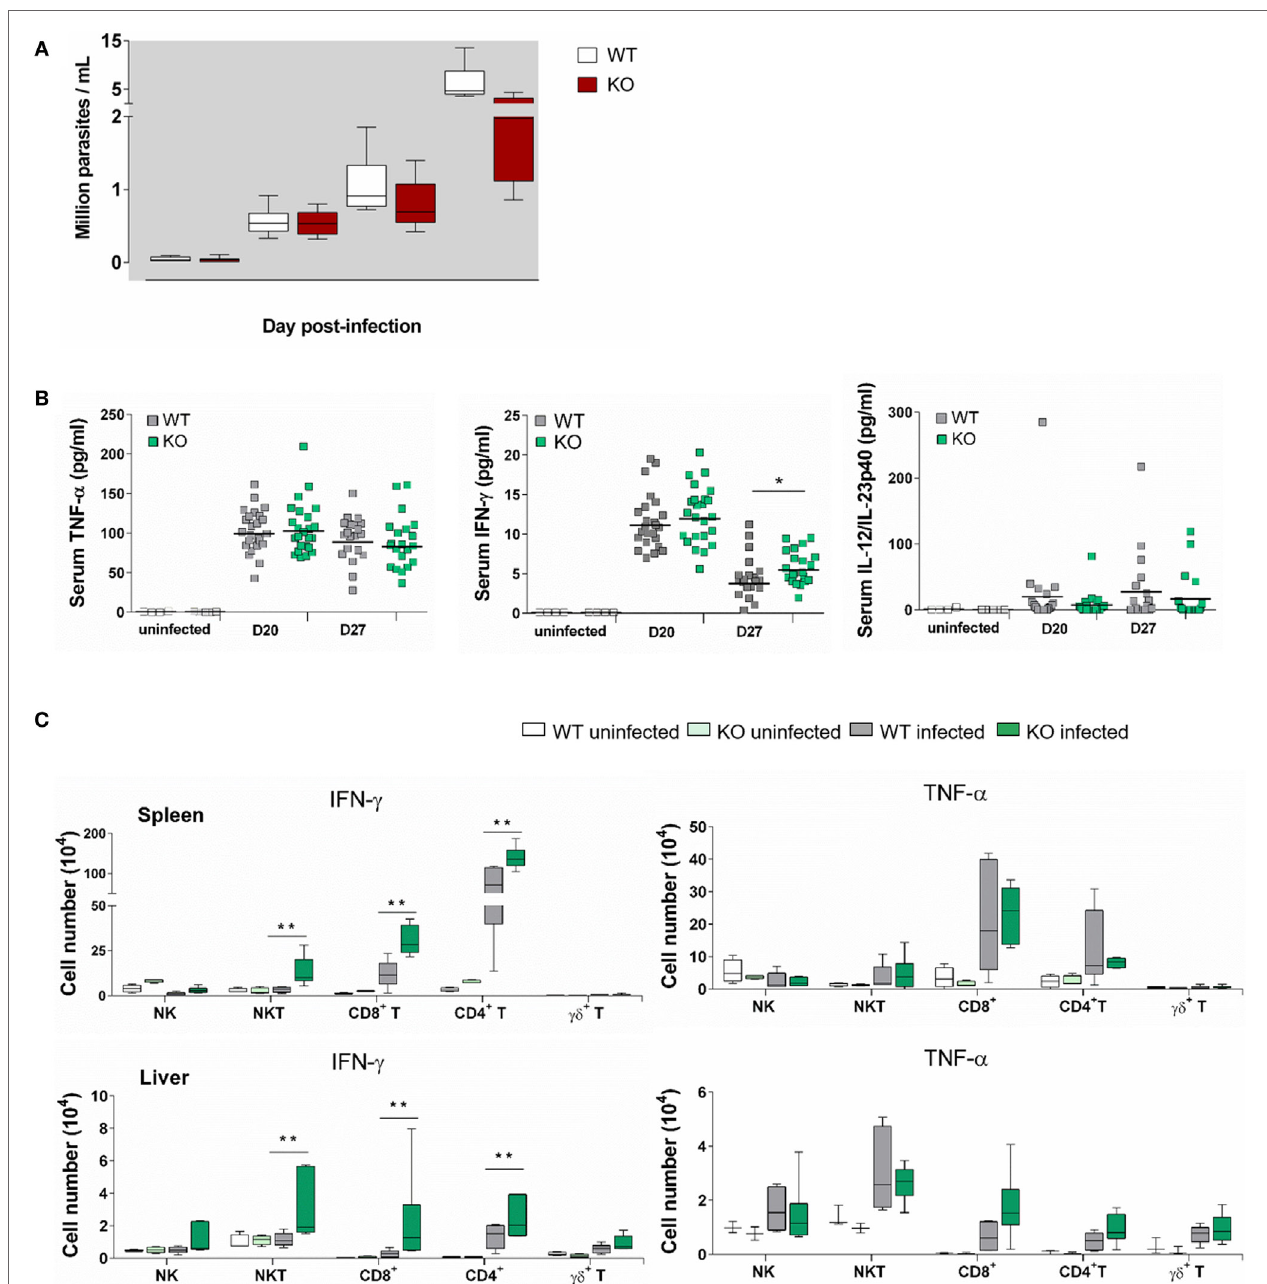
FigUre 4 | enhanced iFn- γ production in T. cruzi -infected ly49e KO mice compared to their WT controls . Four-week-old male WT and Ly49E KO mice were inoculated s.c. with 50 trypomastigotes at day 0. (a) Blood parasitemia levels are shown at the indicated time points (WT, n = 24; Ly49E KO, n = 24). (B) Plasma levels of the indicated cytokines were determined in non-infected mice (WT, n = 3; Ly49E KO, n = 3) and at day 20 (WT, n = 24; Ly49E KO, n = 24) and day 27 post-infection (WT, n = 21; Ly49E KO, n = 21). (c) Intracellular IFN- γ and TNF- α were determined by flow cytometry at day 27 post-infection (WT, n = 6; Ly49E KO, n = 6). The results are presented as the absolute cell number of IFN- γ - (left panels) and TNF- α -positive cells (right panels) in the indicated lymphocyte subpopulations in either spleen (upper panels) or liver (lower panels). Statistical analysis was performed using the Mann–Whitney U -test (* p < 0.05 and ** p <